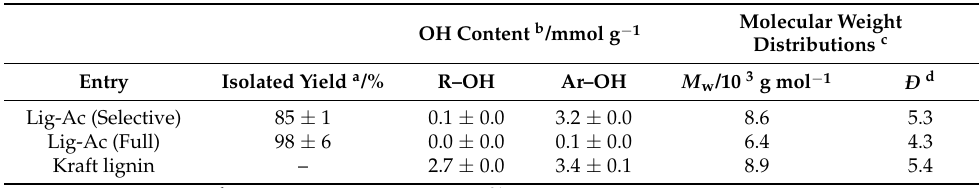
Table 1. Average yields, OH contents, and molecular weight distributions of Kraft lignin and acetyl